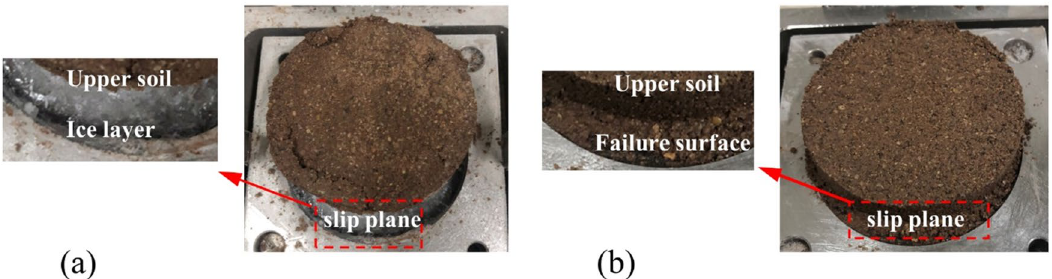
Figure 11. Location of shear failure surface: ( a ) soil-ice interface; ( b ) in the upper soil